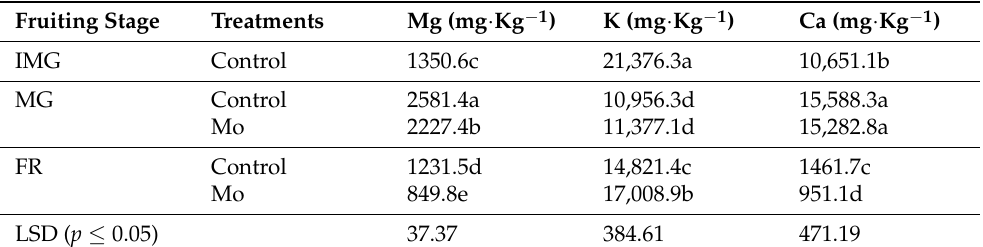
Table 11. Effect of foliar application of molybdenum on macronutrient concentrations in seeds of